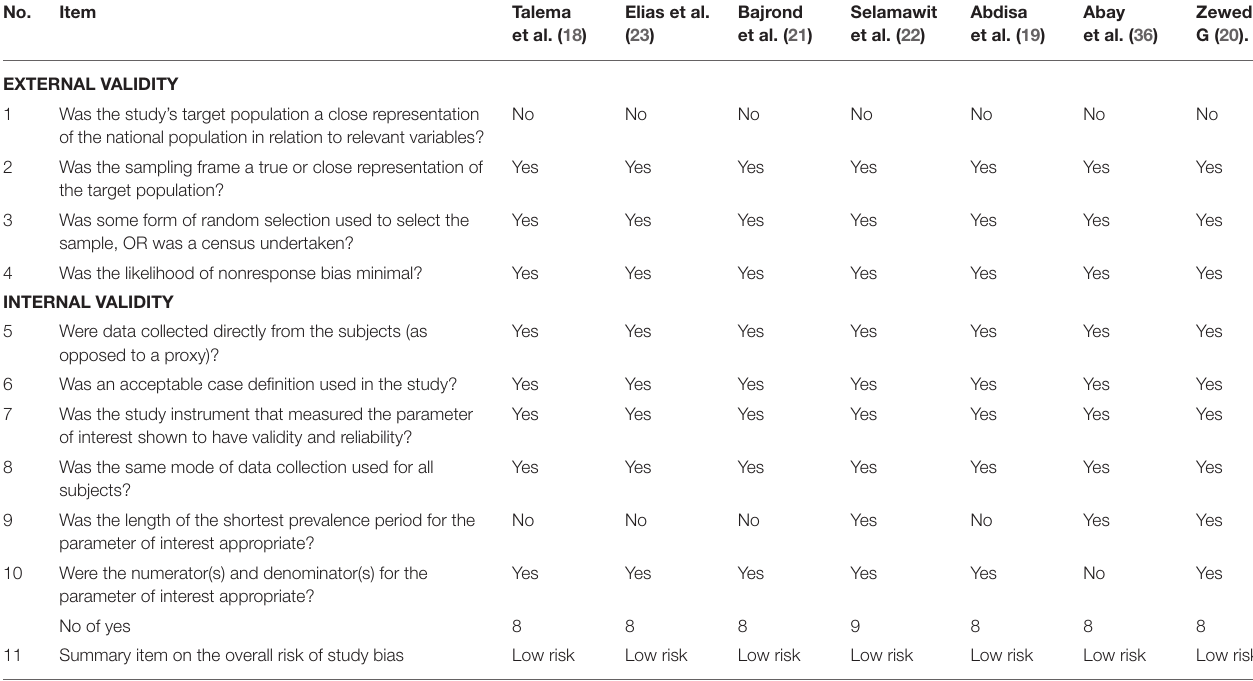
TABLE 3 | Result of risk of bias assessment.